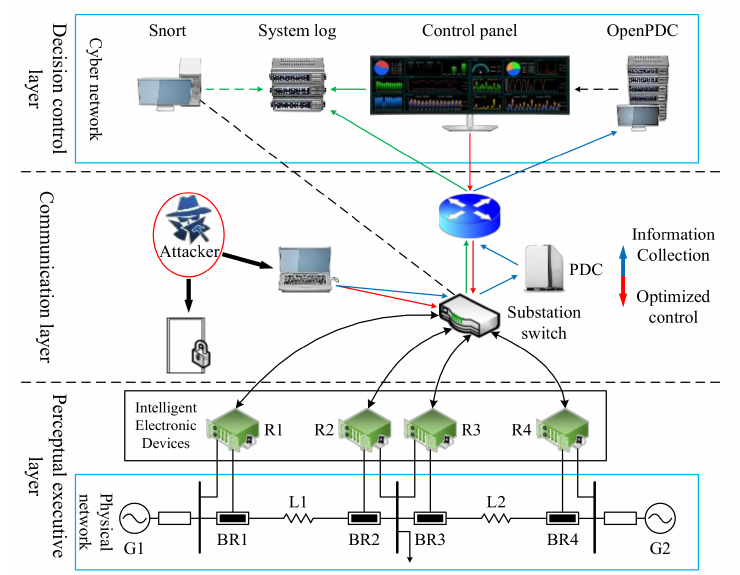
Figure 9. Schematic diagram of the power CPS simulation system structure.